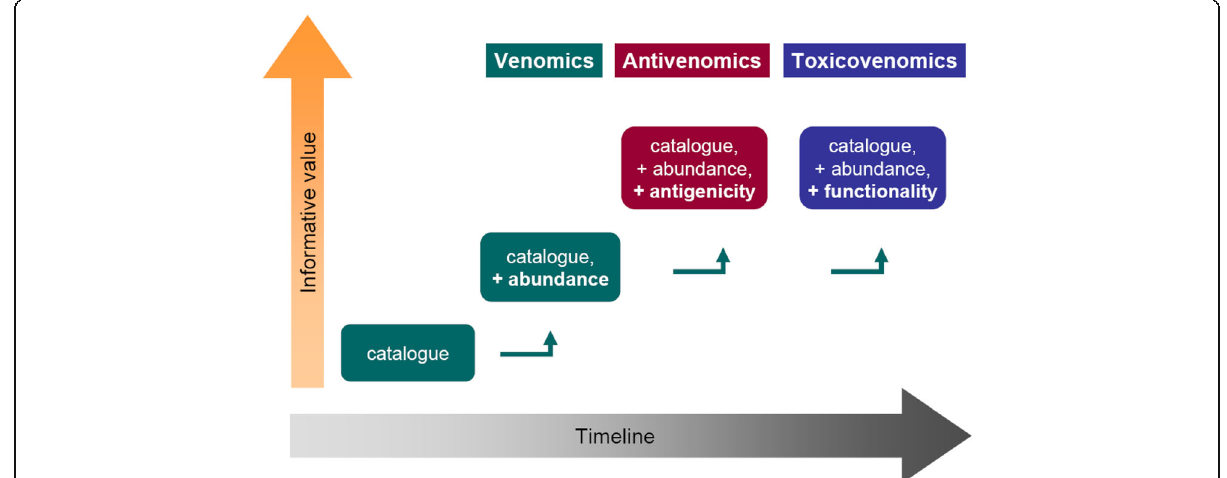
Fig. 4 Evolution of analytical strategies in the characterization of snake venoms by proteomic tools, used in combination with appended methodologies. Initial proteomic studies on venoms essentially focused on the qualitative cataloguing of components. The introduction of the snake venomics strategy led to a valuable increase in the informative value of these analyses, by providing an estimation of the abundances of venom components. In combination with antivenomics, the immunogenicity of venom components can be inferred by evaluating their recognition by antibodies present in a given antivenom. A third dimension in the characterization of venoms is provided by a combination with toxicovenomics, which evaluates the toxic activities of components. Altogether, these combined strategies increase the informative value of studies characterizing venoms by disclosing their composition (venomics), immunorecognition (antivenomics) and toxicity